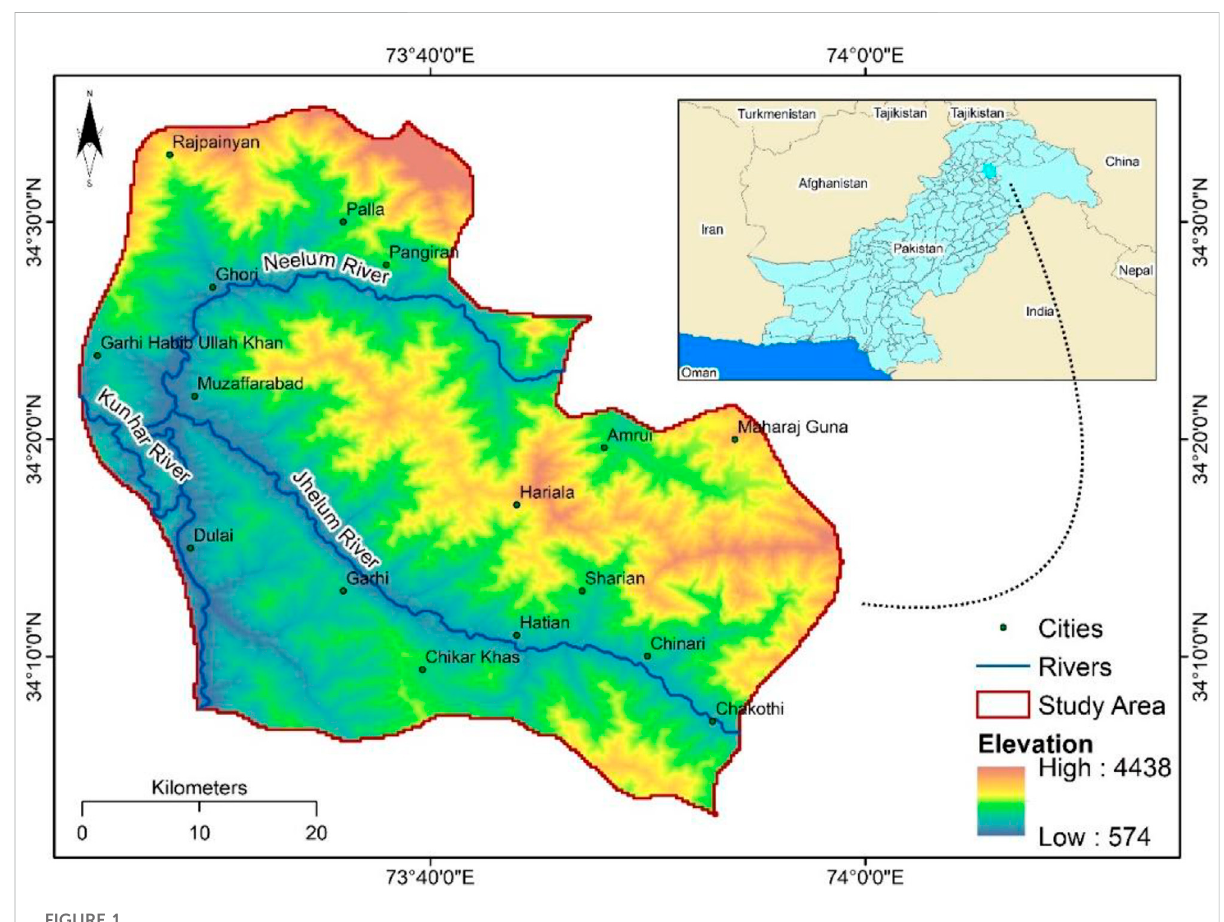
FIGURE 1 Map of the study area showing the elevation and the rivers of the